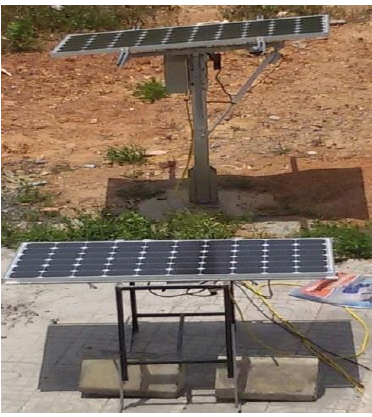
Figure 1. Sun tracking and fixed-tilted PV systems.